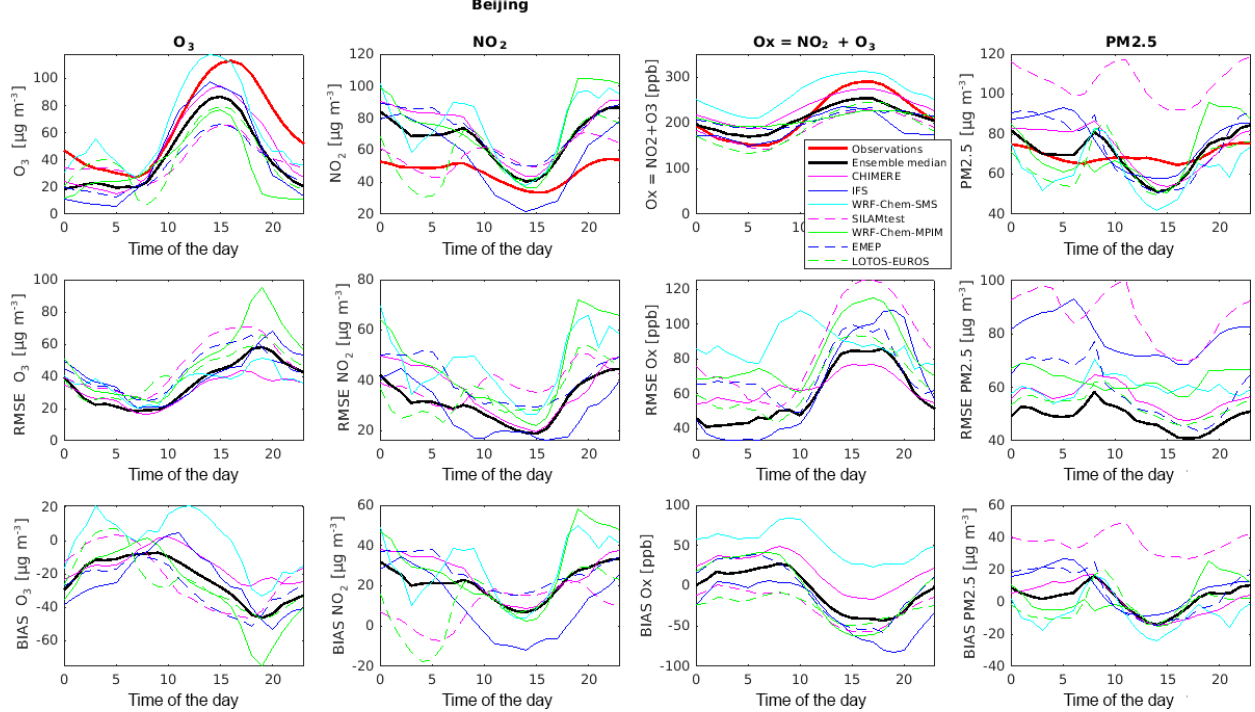
Figure 8. Diurnal variations in the concentrations and of the RMSE and BIAS of O 3 , NO 2 , O x , and PM 2 . 5 for Beijing for the whole time period (April 2016–June